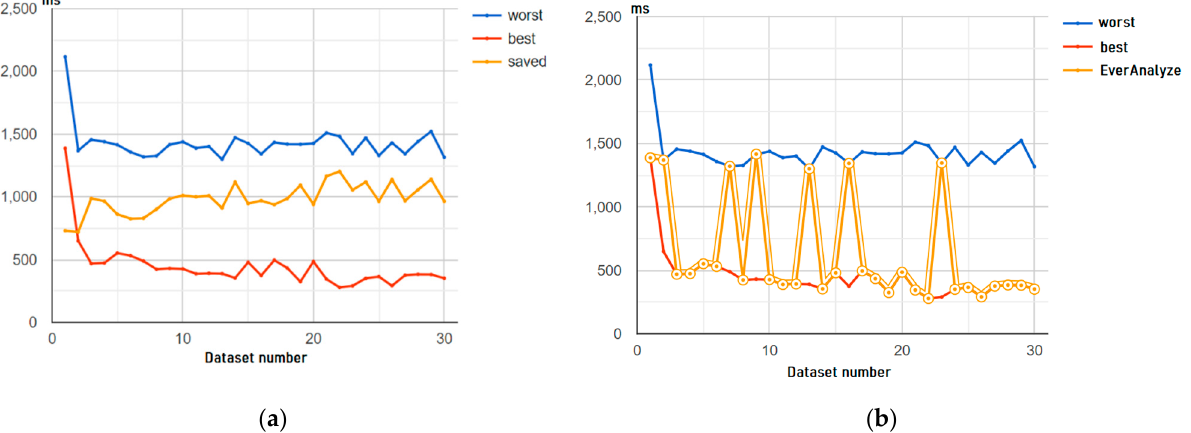
Figure 26. ( a ) Worst—best execution with best speed; ( b ) Worst—best execution with EverAnalyzer.